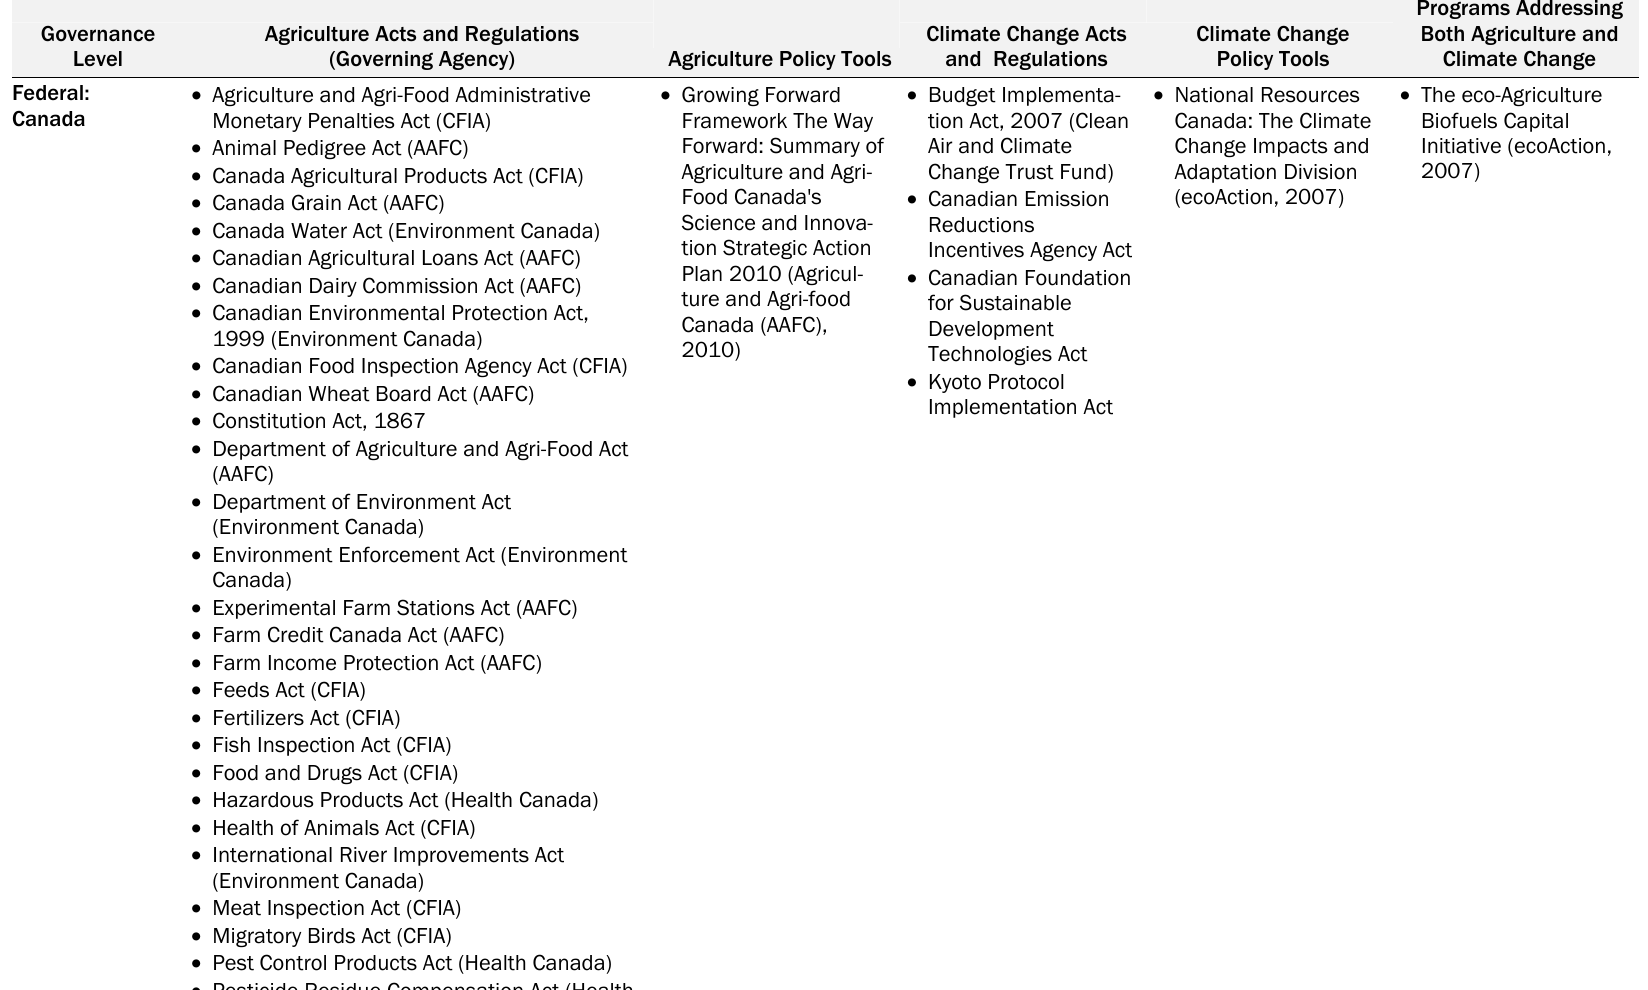
Table 1. Federal, Provincial, and Local Government Policies, Policy Tools and Programs Influencing Agriculture and Climate Change in British Columbia,